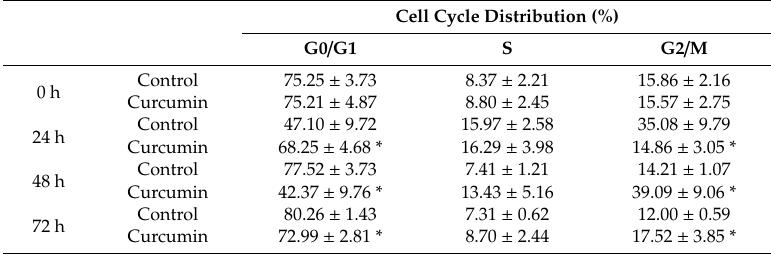
Figure 4. Low dose curcumin inhibits mitotic clonal expansion (MCE) during the early stage of adipocyte di ff erentiation. 3T3-L1 preadipocytes were left untreated ( ) or were pretreated with 15 µ M curcumin ( (cid:4) ) for 1 h, then adipocyte di ff erentiation was induced in the continued presence or absence of curcumin for 0–5 days, when MCE was measured by cell counting ( A ) or the MTT assay ( B ). The results are the mean ± SD for four independent experiments. * P < 0.05 compared to the vehicle control. Table 2. E ff ect of 15 µ M curcumin on the cell cycle of 3T3-L1 preadipocytes. Cell Cycle Distribution (%)